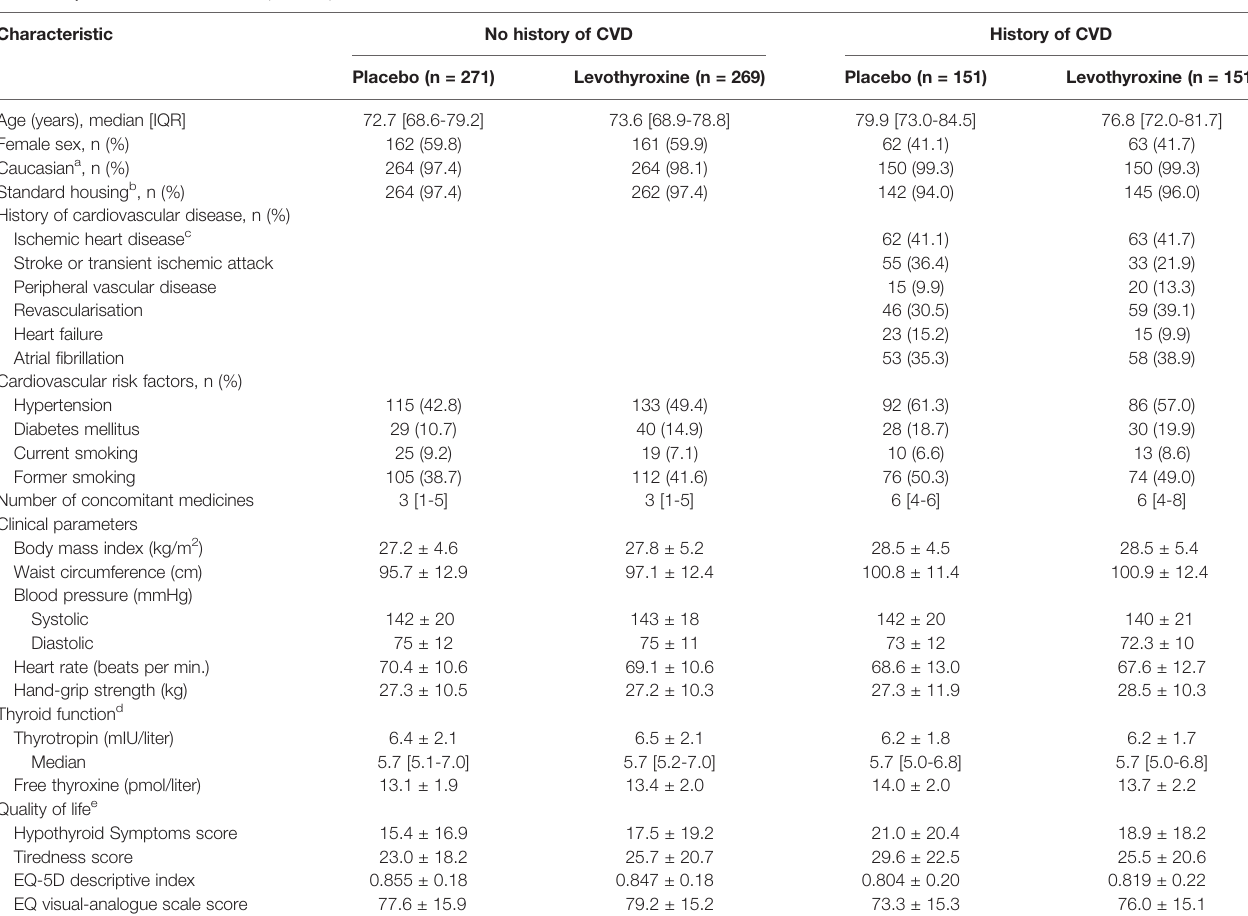
TABLE 1 | Baseline characteristics (n = 842).